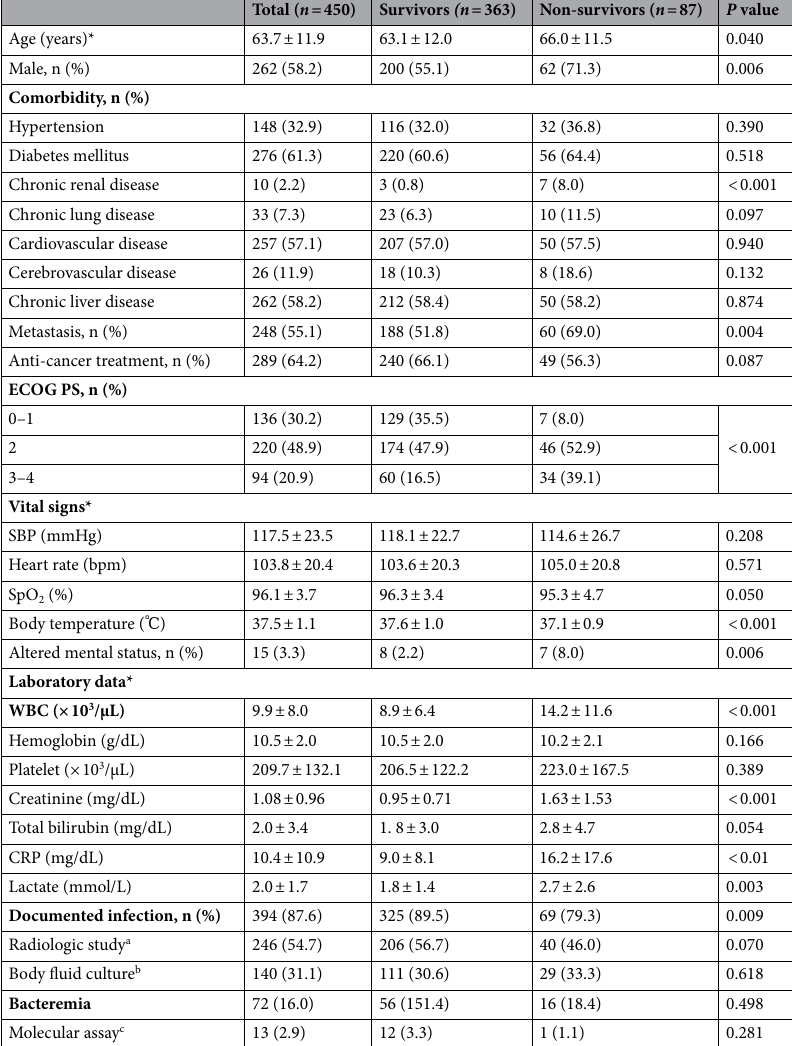
ECOG Eastern Cooperative Oncology Group, PS performance status, SBP systolic blood pressure, SpO 2 peripheral oxygen saturation, WBC white blood cells. a Infection was documented by radiologic